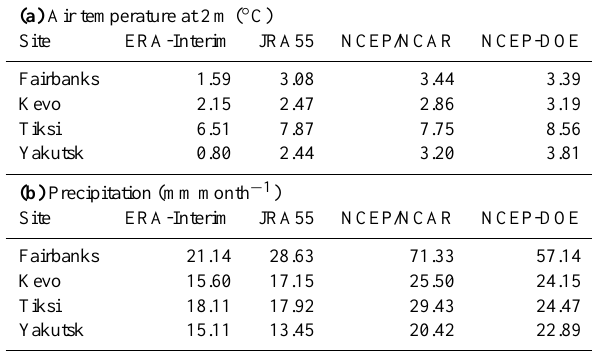
Table 3. Root mean square errors for the correlation between monthly reanalysis data and reference data (CRU for air temper- ature and GPCP for